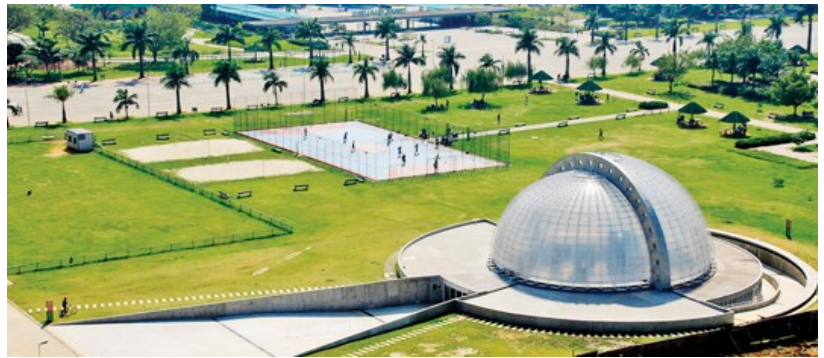
Figure 2. Villa-Lobos State Park [19].